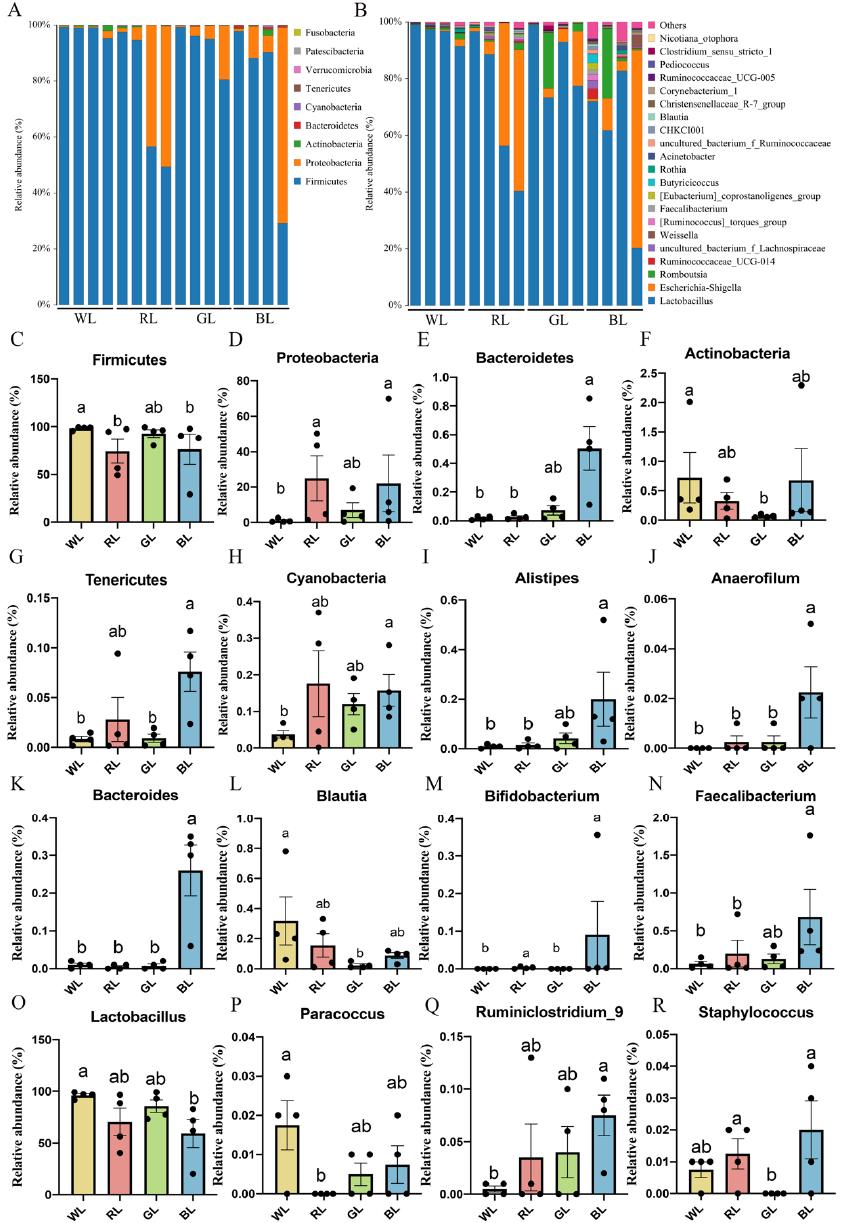
Figure 2. The relative contribution of the top 10 phyla in the WL, RL, GL and BL ( A ). Twenty-two genera were identified that were present at a relative abundance of >0.1% in the WL, RL, GL and BL ( B ). Taxonomic profiles of the notably significantly different bacteria at the phylum level ( C – H ) and genus level ( I – R ). WL: white light; RL: red light; GL: green light; BL: blue light. These results are shown as means ± SEM. Differences between the four groups are presented in the form of different letters ( p < 0.05).